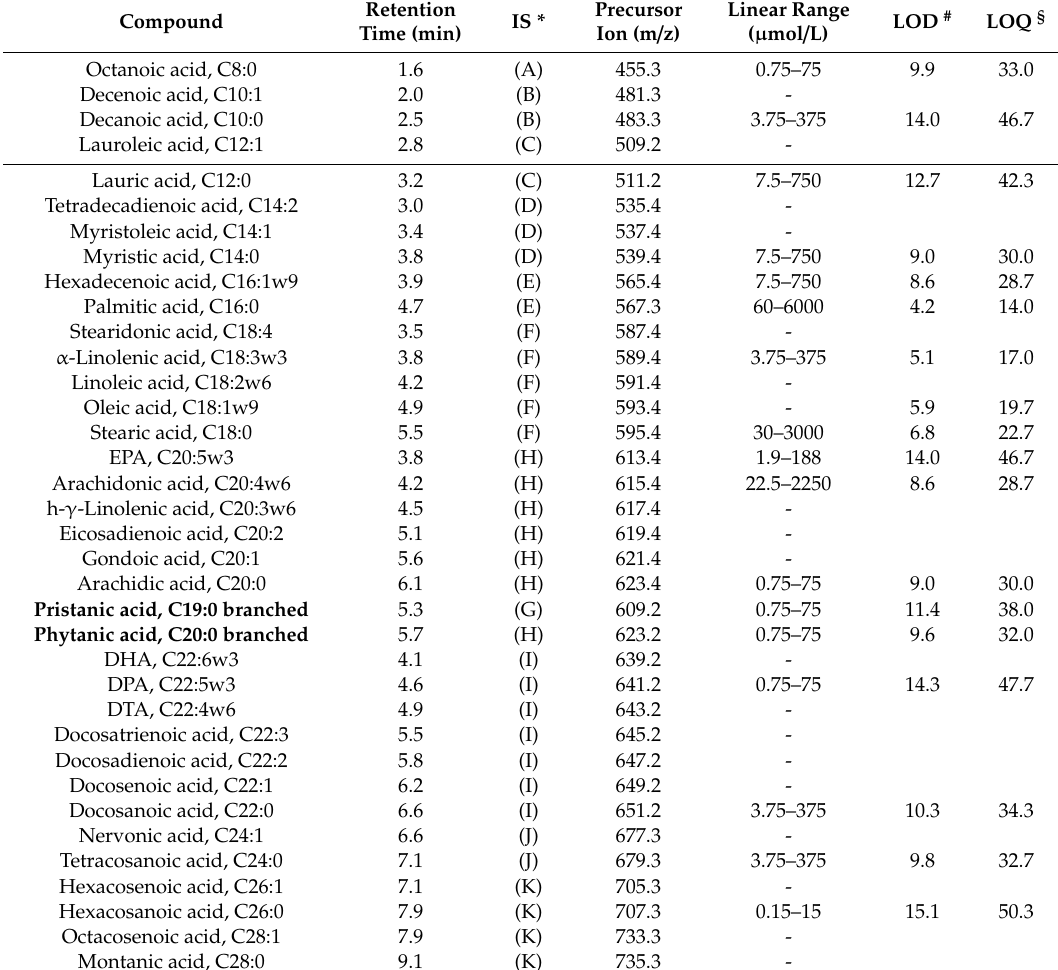
Table 1. Retention times, m / z of precursor ion, internal standard (IS), and linear range of studied FAs.